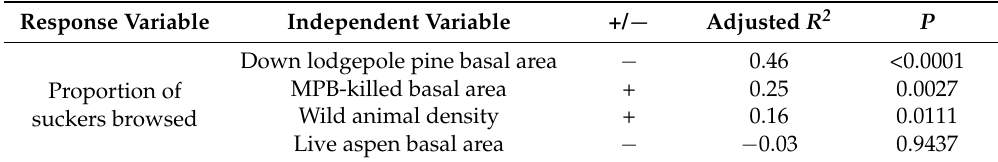
Table 3. Results of linear regression analysis between proportion of suckers browsed (in each stand) and independent variables. All independent variables shown had a significant ( α < 0.1) Spearman’s rank correlation with proportion of suckers browsed. Signs (+ or − ) indicate if regression relationship is positive or negative. All variables met assumptions of normality. Proportion of suckers browsed was transformed with an arcsine square-root transformation. All independent variables were log-transformed except for wild browsing